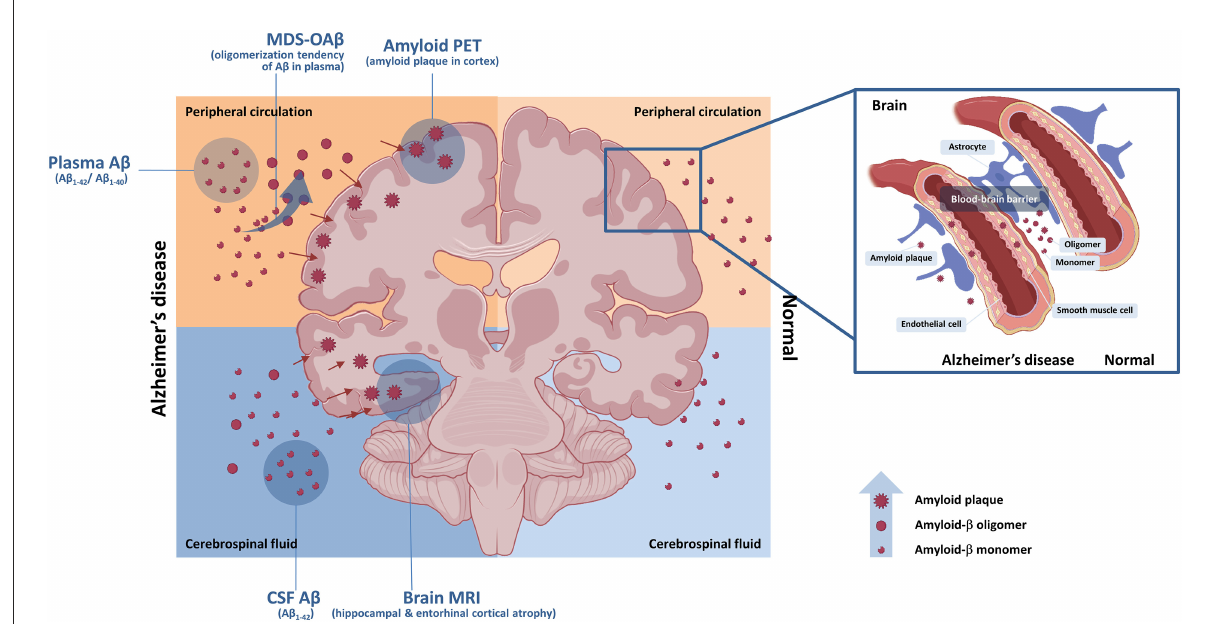
FIGURE1 Central and peripheral amyloid- β and biomarkers. Central and peripheral A β can be detected by various biomarkers. A β oligomerization tendency in plasma can be detected by MDS-OA β . Concentration of A β in CSF can be measured by CSF study with spinal tapping. Accumulation of A β plaque in brain can be evaluated by amyloid PET. Impaired blood–brain barrier can contribute to acceleration of amyloid pathology. A β , amyloid- β ; CSF, cerebrospinal fluid; MDS-OA β , Multimer Detection System-Oligomeric Amyloid- β ; MRI, brain magnetic resonance imaging; PET, positron emission